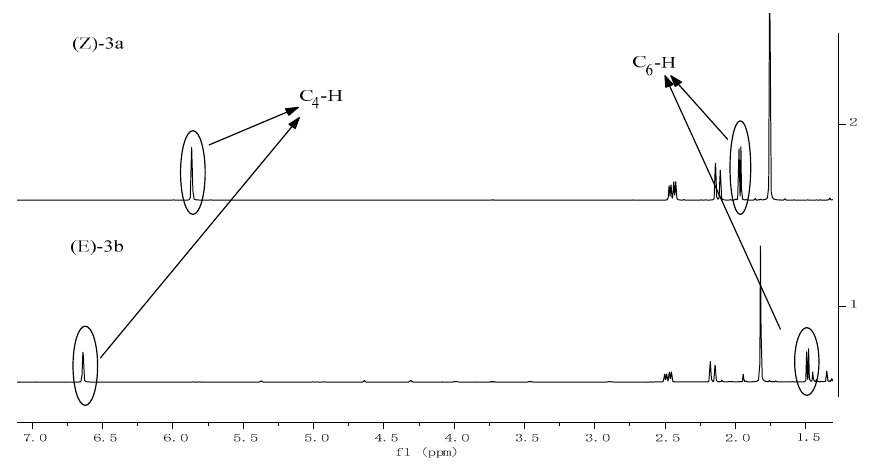
Figure 1. 1 H-NMR spectra of ( Z )- 3a and ( E )- 3b .